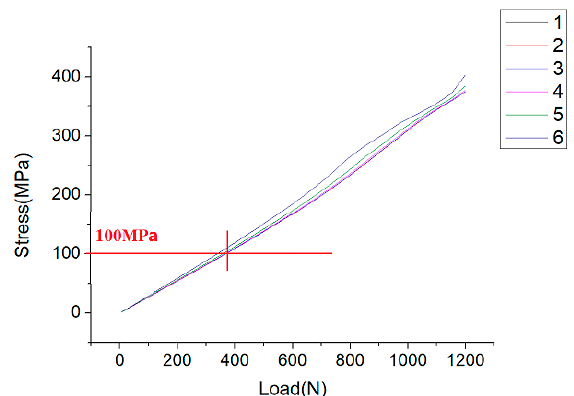
Figure 11. Location of nodes.